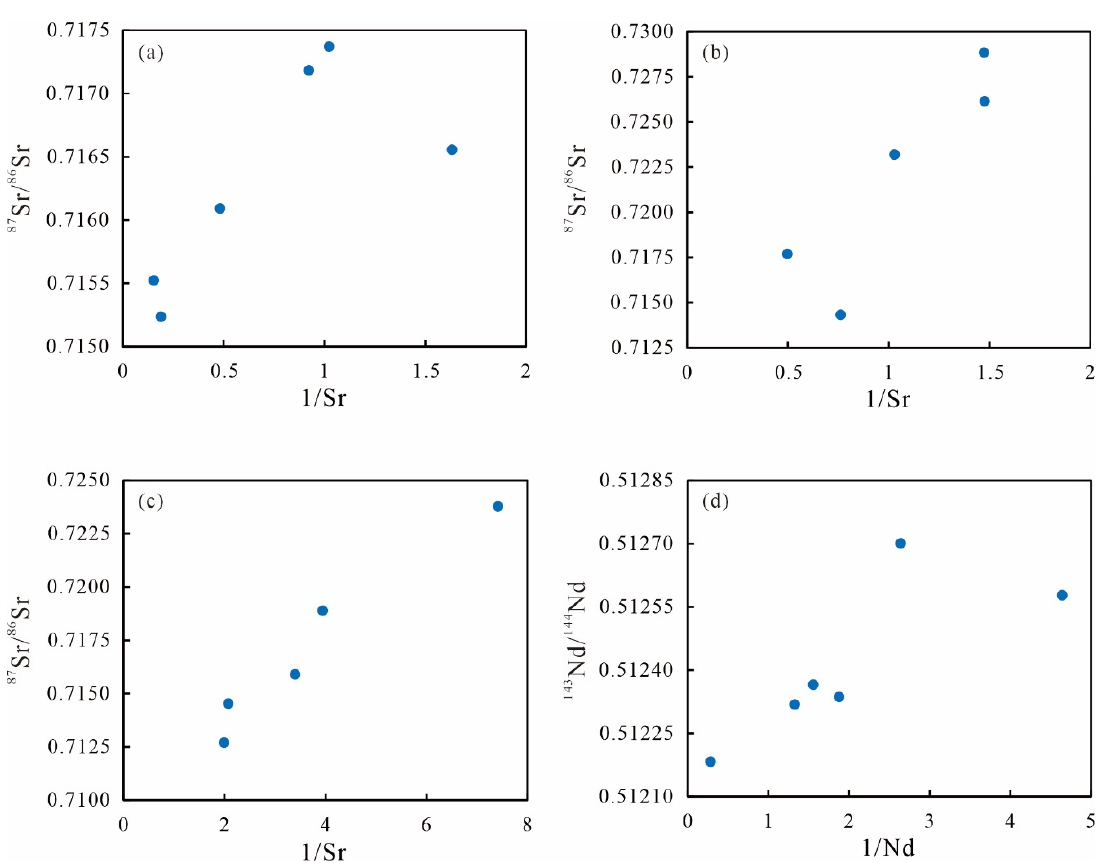
Figure 8. 87 Sr/ 86 Sr vs. 1/Sr diagrams for ( a ) paragenetic sphalerites and pyrites from the Liuhuang- dong orebody in the Laochangping Pb-Zn deposit, ( b ) paragenetic sphalerite and pyrites from the Wanbao orebody in the Laochangping Pb-Zn deposit and ( c ) sphalerites from the Laoxi orebody in the Luota Pb-Zn deposit. ( d ) 143 Nd/ 144 Nd vs. 1/Nd diagrams for paragenetic fluorites and calcite from the Wujiahe orebody in the Luota Pb-Zn deposit. Note that the plots show no linear relationships, ruling out the possibility of two-component mixing and suggesting that the Rb-Sr and Sm-Nd isochron ages in Figure 7 are geologically meaningful. Table 3. Analytical data of Rb-Sr isotopic ratios and Rb-Sr concentrations s of the sulfide samples from the Laochangping and Luota Pb-Zn deposits.